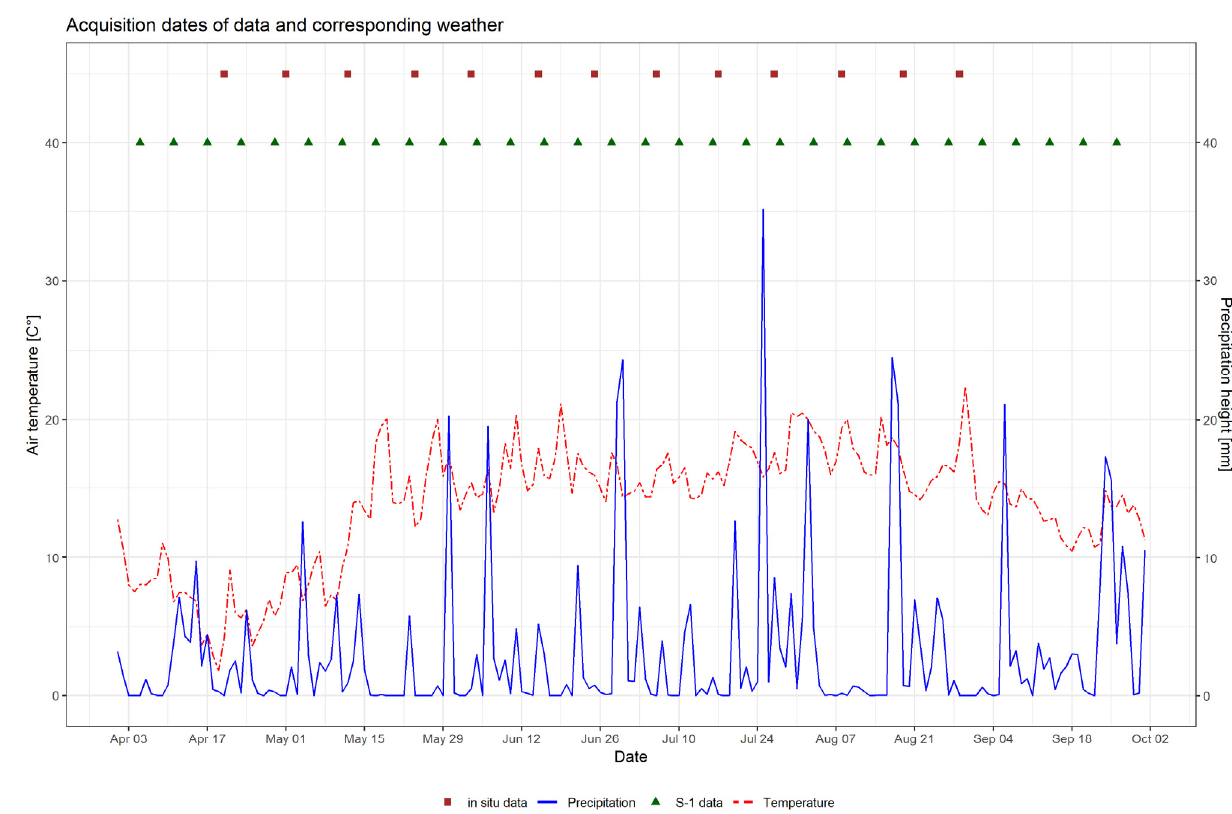
Figure 2. Development of daily mean air temperature [°C] and daily precipitation [mm] for the growing season of 2017, and acquisition dates of field sampling and Sentinel-1.